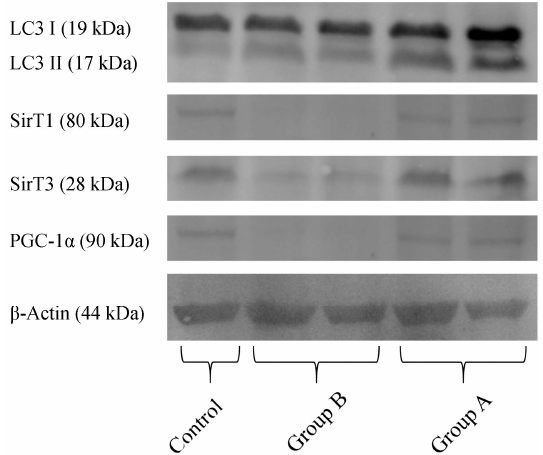
Figure 10. The effect of BBR addition in the preservation solution before ischemia on the content of LC3, Sirt 1 and 3, PGC-1 α , as evaluated by Western blot. Tissue samples were obtained from animals sacrificed after 12 h of hepatic exposure to preservation solution and 1 h of reperfusion, as described in the Materials and Methods Section. Control animals were sham operated. I/R livers (Group B) had a reduced content in SirT1, SirT3 and PGC-1 α (all these effects were prevented by BBR addition; Group A). The active form of LC3 (LC3 II) was elevated in Group A (BBR addition), when compared to Group B (I/R). The image shows a representative Western blot of these experiments for the respective proteins, from six independent experiments.